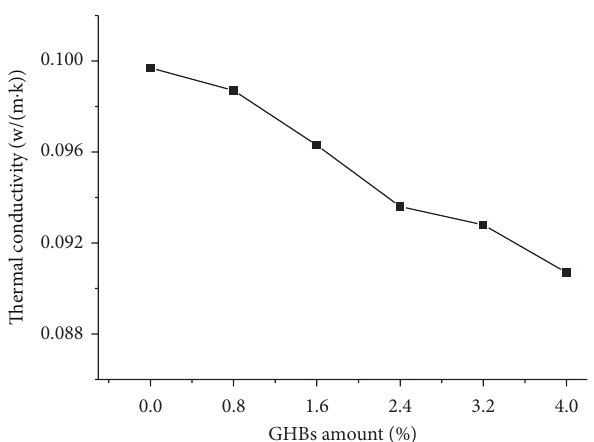
Figure 10: Effects of GHBs on thermal conductivity of the test